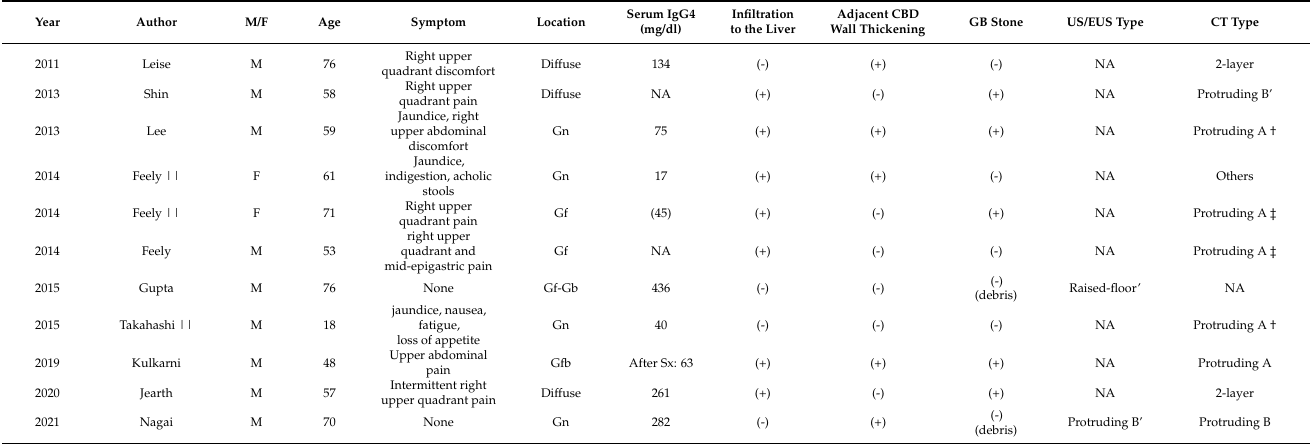
Table 2. Previous reports on IgG4-related sclerosing cholecystitis without autoimmune